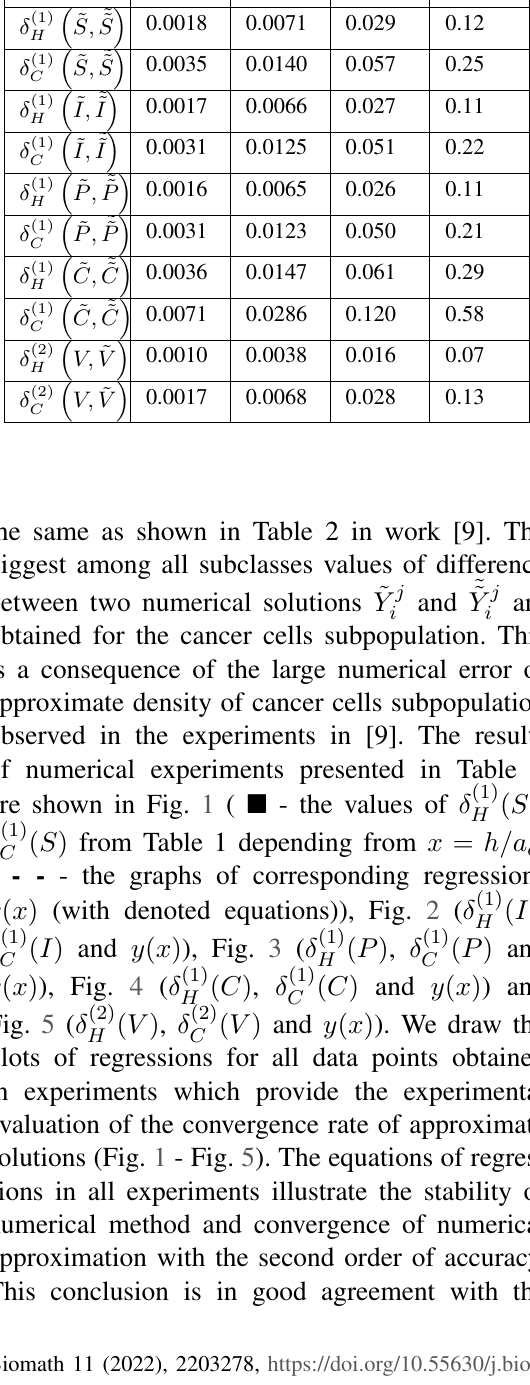
( S ) , δ (1) ( S ) , - - - graphs of H C